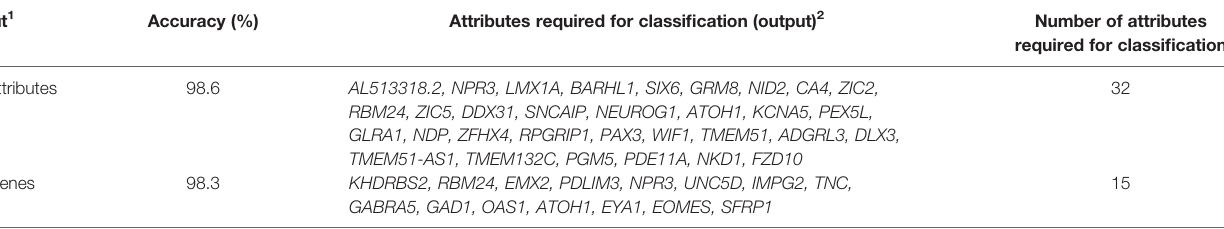
TABLE 2 | The accuracies of the top setof attributes selected for classi fi cation by the SARC algorithm for each input, based on the GSE85217 dataset (n= 763 MBsamples). Input 1 Accuracy